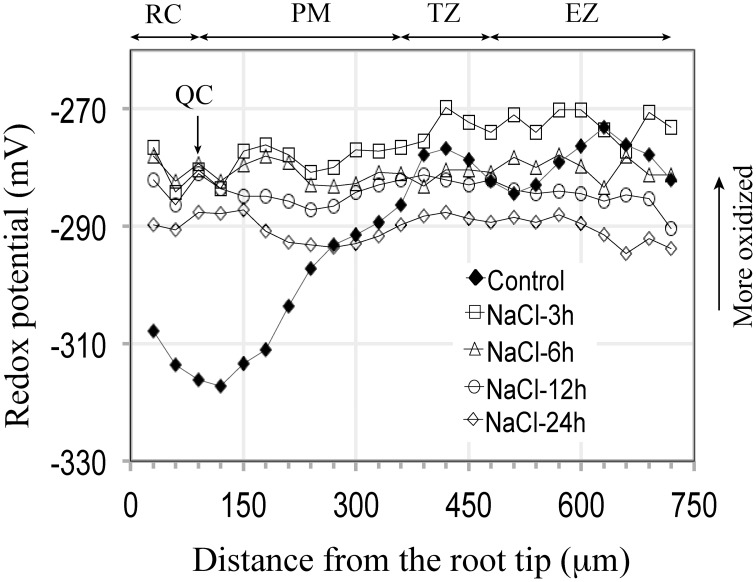
Redox potential profiles of Arabidopsis primary roots grown 5 days on soild agar and then immersed in 100 mM NaCl for varying periods of time (3–24 h). For all periods of exposure the redox status of the entire root becomes more oxidized, with the greatest change occurring in the terminal 300 μm (Compared to control curve from Figure 1). Each salt treatment redox profile curve represents an average from 7 to 8 roots, for which the standard deviations are shown in Supplementary Figure 2.